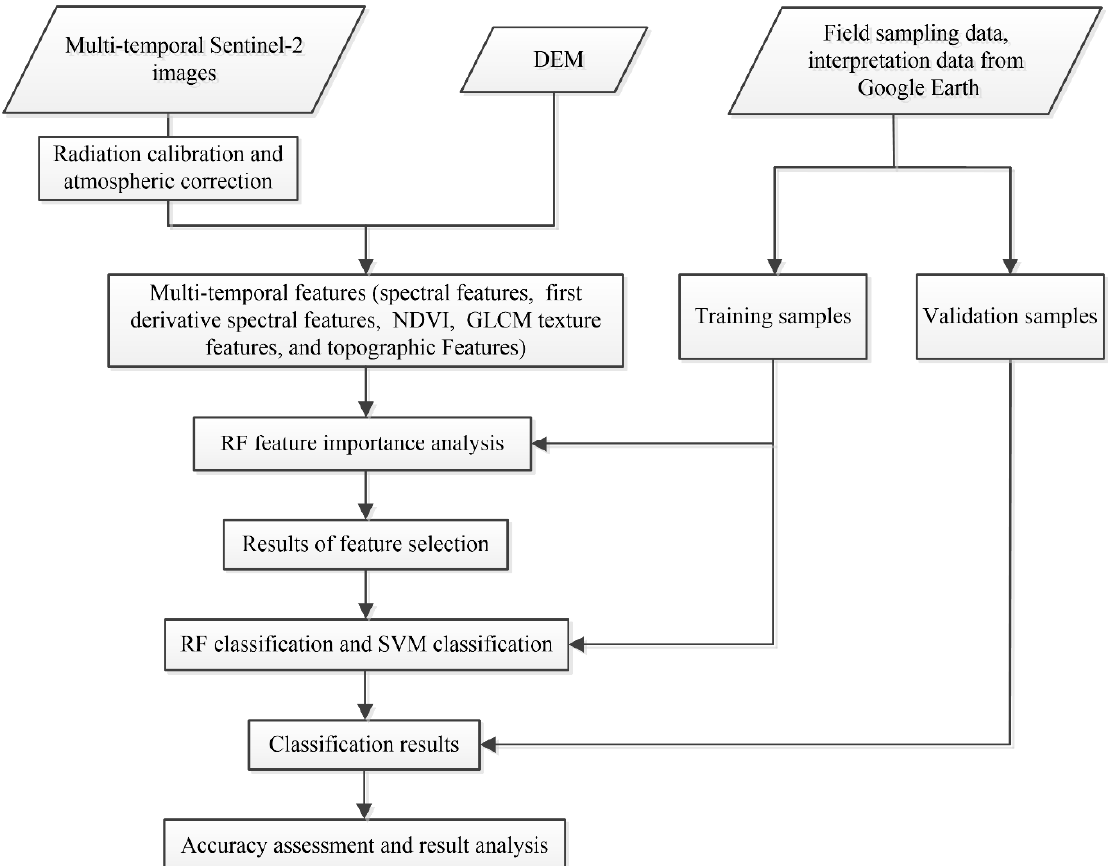
Figure 5. Flowchart for the tea plantation identification method proposed in this study.